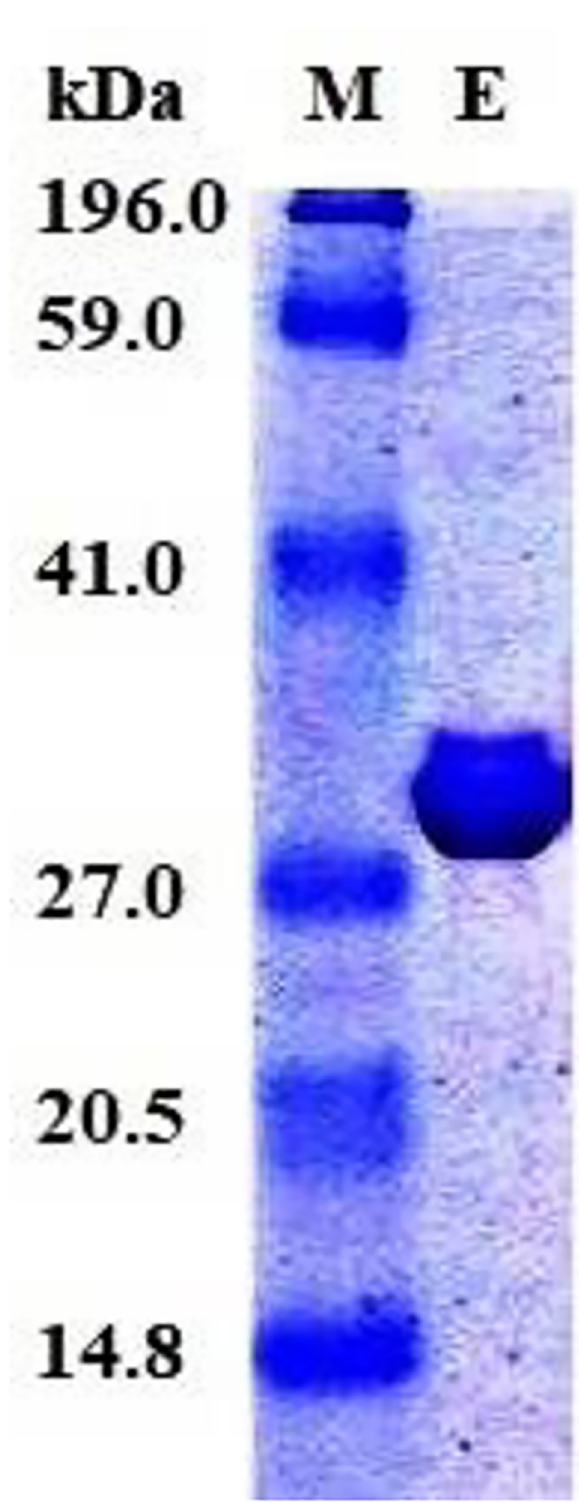
Fig 1. SDS–PAGE of the purified elastase using a 5% stacking gel and a 15% separating gel.